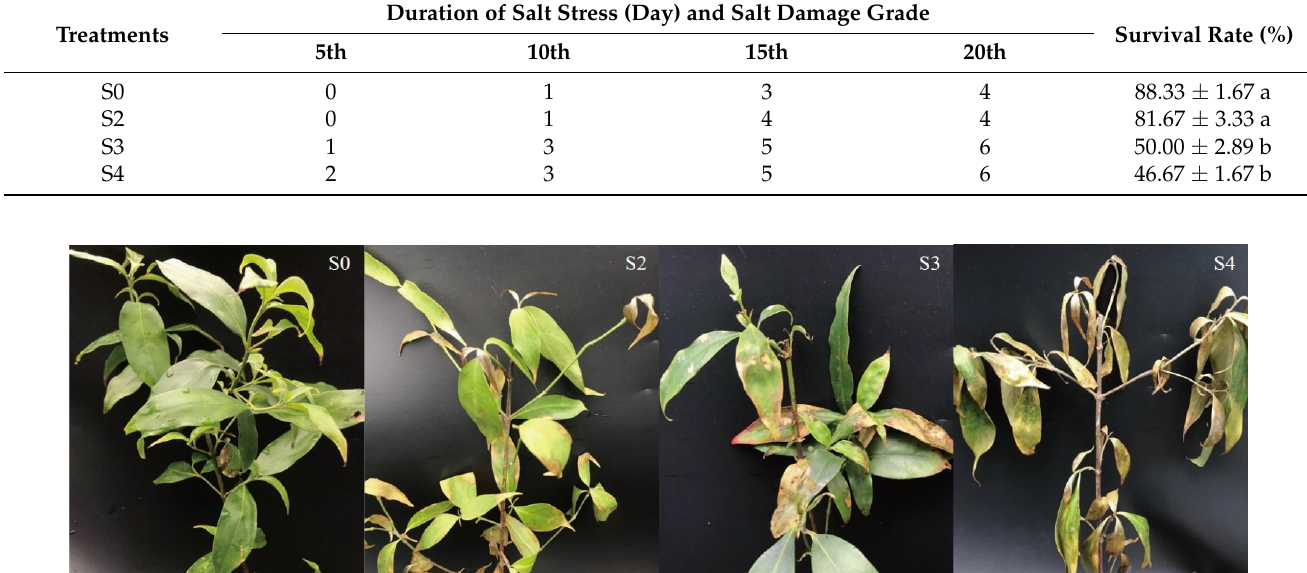
Figure 3. Damage symptoms in the leaves and branches in Cornus hongkongensis subsp. elegans (W. P. Fang et Y. T. Hsieh) Q. Y. Xiang seedlings. The photos were taken at the end of the experiment. S0, S2, S3, and S4 indicate control, 0.2%, 0.3%, and 0.4% salt concentration treatments, respectively.